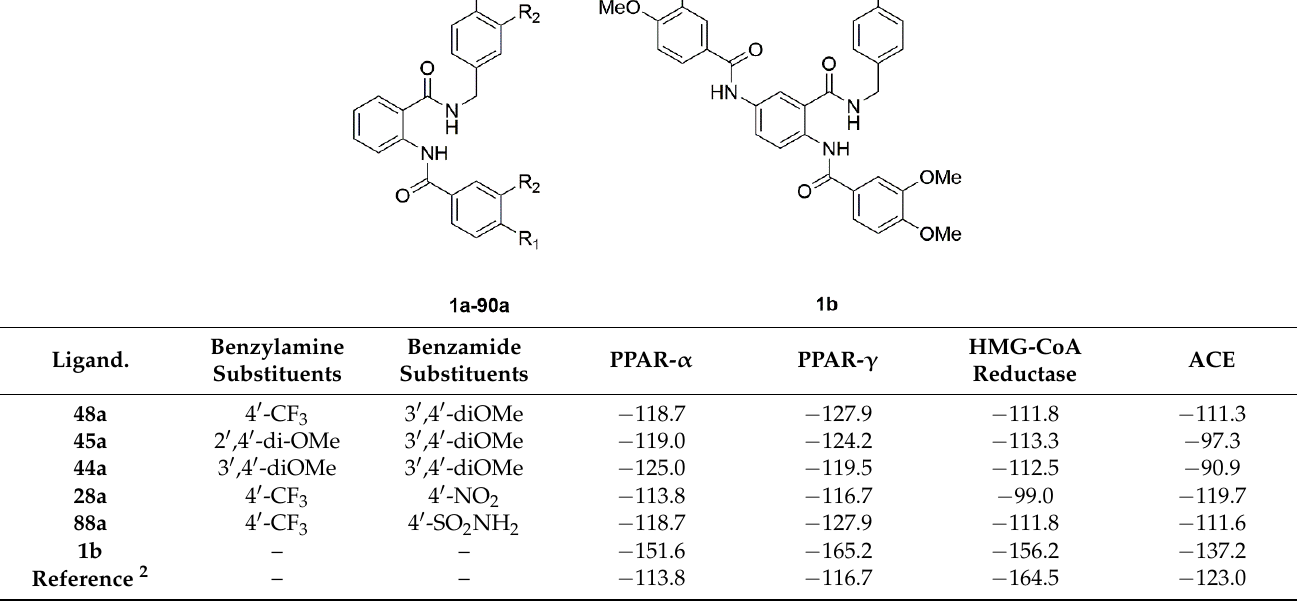
Table 1. Docking scores of the ligands with higher theoretical affinity against some targets related to MetS 1 .